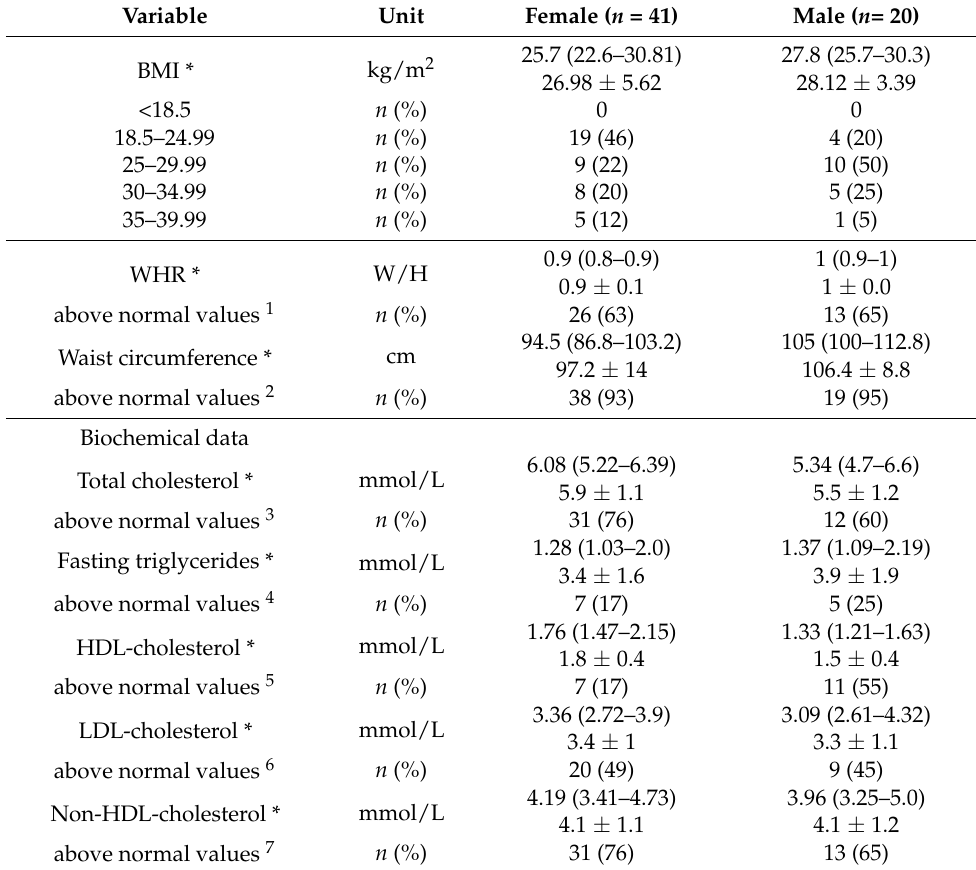
Table 2. Anthropometric and biochemical parameters in patients with rheumatoid